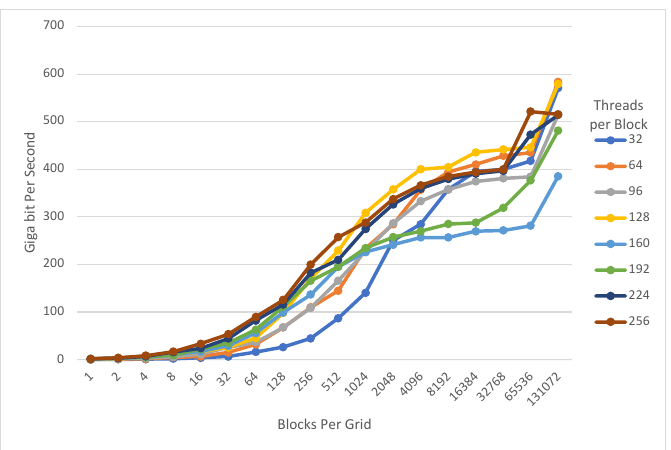
Figure 6. GIFT-64 exhaustive key search: Comparison of the number of key-search per second.